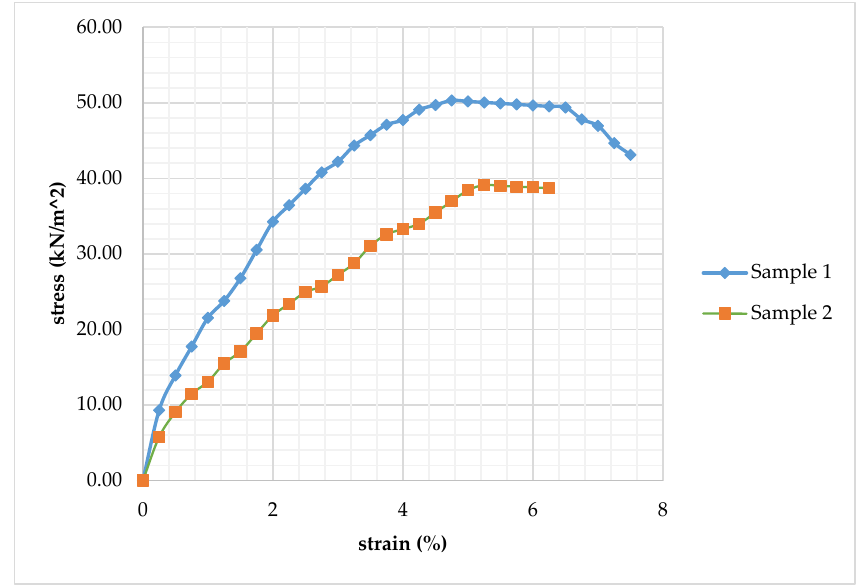
Figure 7. Stress-strain curve of the natural soils from the unconfined compression test.